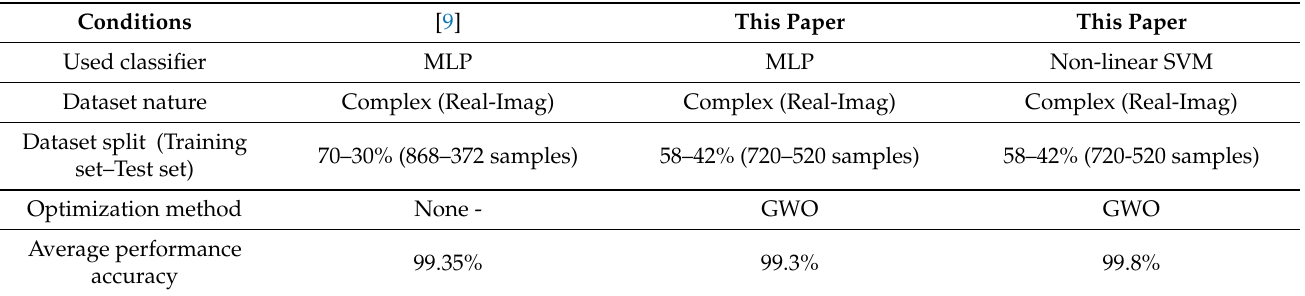
compared to what was followed in